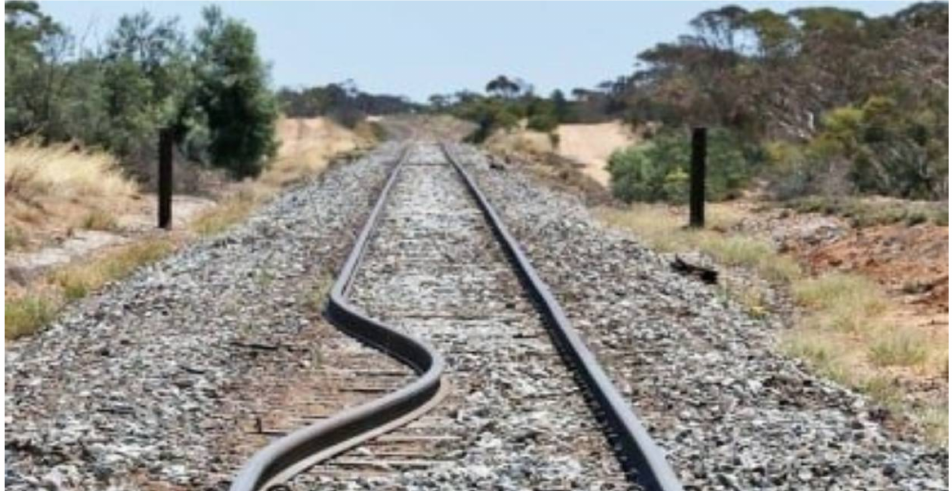
Figure 2. Track buckling due to high temperatures (source: